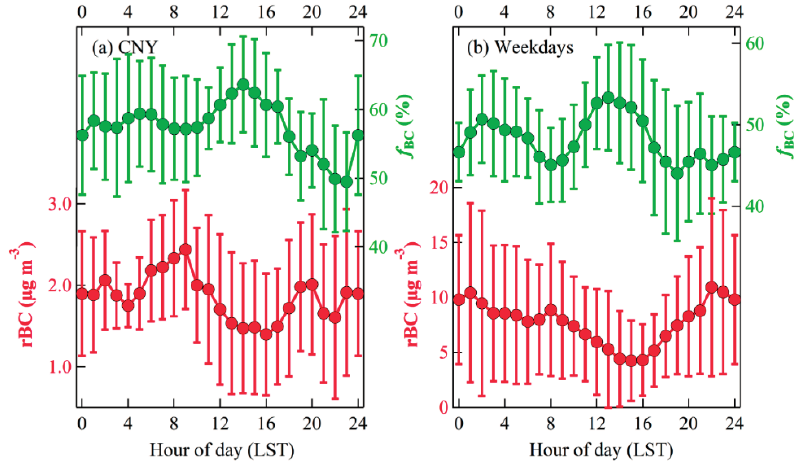
Figure 4. Diurnal variations of hourly averaged rBC mass (red dots) and the number fraction of thickly-coated rBC particles ( f BC ) (green dots) during ( a ) the Chinese Lunar Year and ( b ) on weekdays. Vertical lines indicate one standard deviation. LST stands for local standard